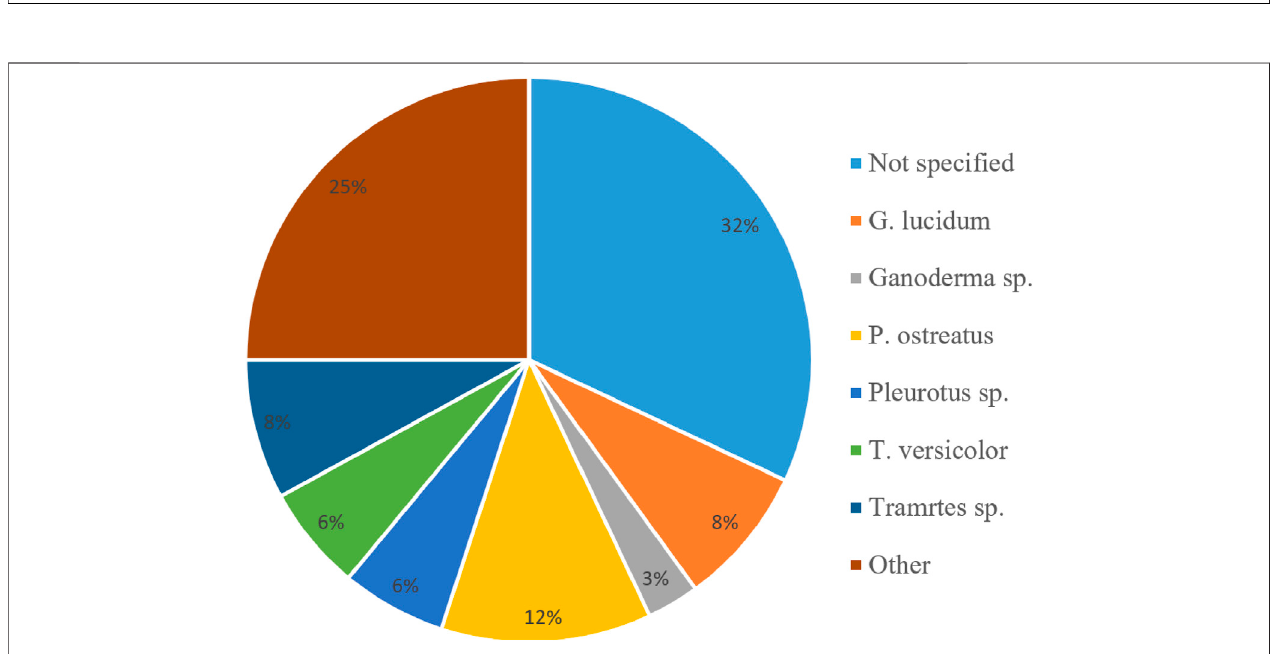
FIGURE 4 | The main fungal species used for fabricating mycelium composites in the literature of the current review paper. Structural features of mycelium at different scales.